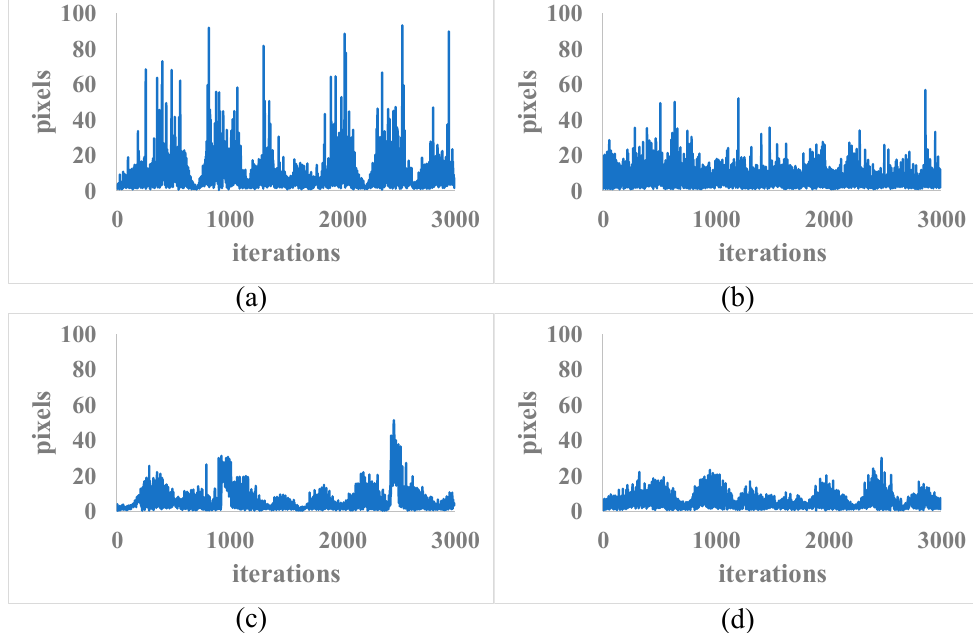
Figure 19. Joint angles and joint velocity of the improved PHUVS with the KF-SVSF method in the tracking experiment of a triple leaf rose path. ( a ) Joint angles. ( b ) Joint velocities.